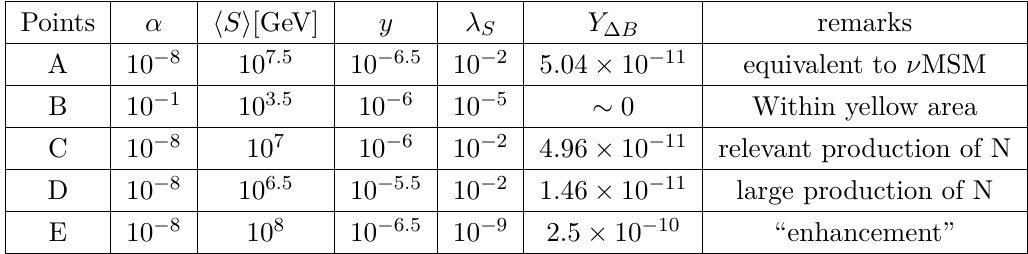
Table 2. Considered parameter space points A, B, C and D . The parameters are the relative mass splitting α , the sterile neutrino Yukawa coupling Y , the zero-temperature vev of the scalar singlet v 0 , the scalar singlet self coupling λ S . Given are the produced Baryon Asymmetry of the Universe S Y ∆ B for each point, where the scalar-Higgs coupling λ SH = 10 − 3 has been